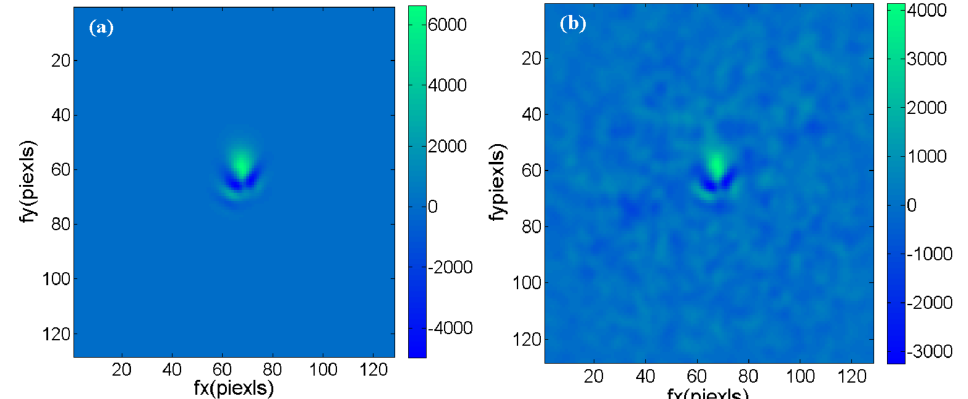
Figure 3. The filtered frequency distribution of Figure 2c,d where ( a ) is the filtered frequency distribution of Figure 2c; ( b ) is the filtered frequency distribution of Figure 2d.